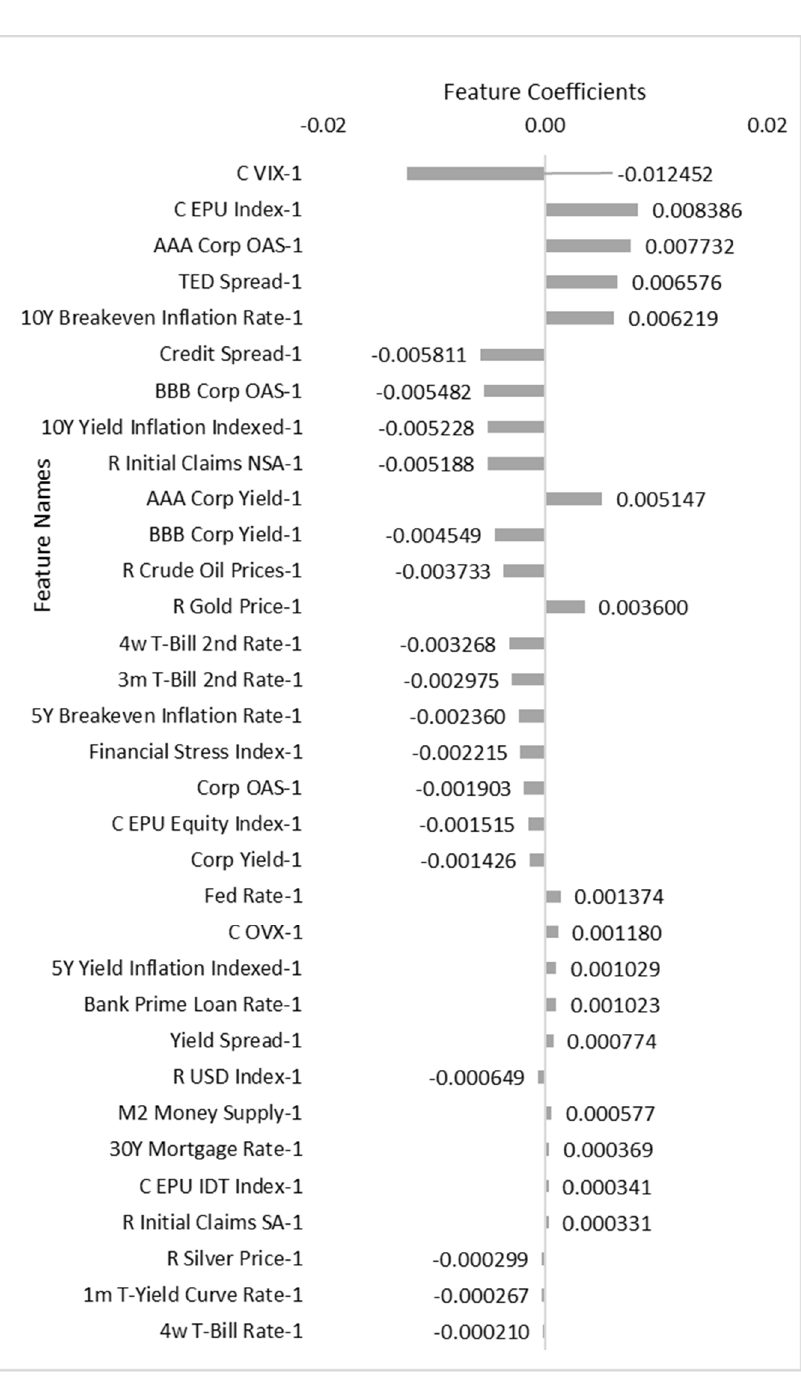
Figure 8. Top thirty-three weekly ranked features from logistic regression. The displayed numbers, truncated to four decimal places, are the features’ coefficients. truncated to four decimal places, are the features’